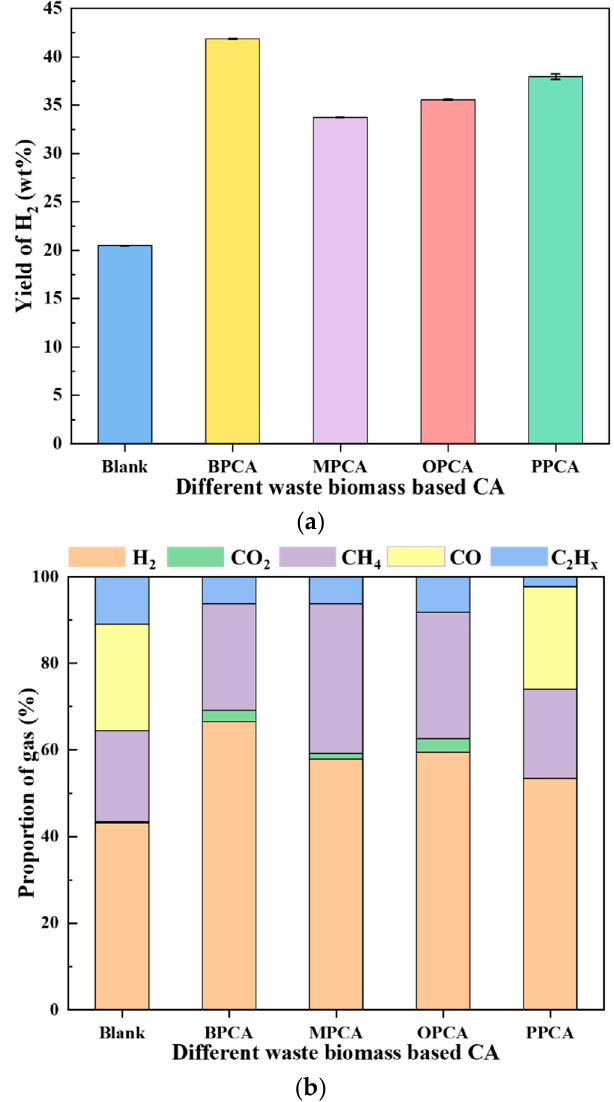
Figure 2. The yields of H 2 ( a ) and gas products proportions ( b ) with CAs prepared from different waste biomass.